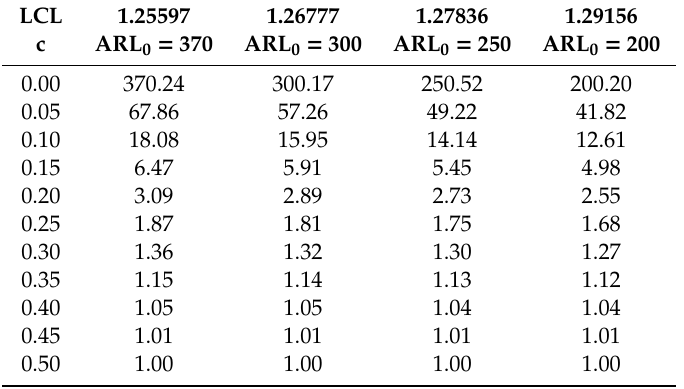
Table 18. The ARLs for the proposed chart when n = 50, LND (0.95,0.40), USL = 7.2452, and LSL =